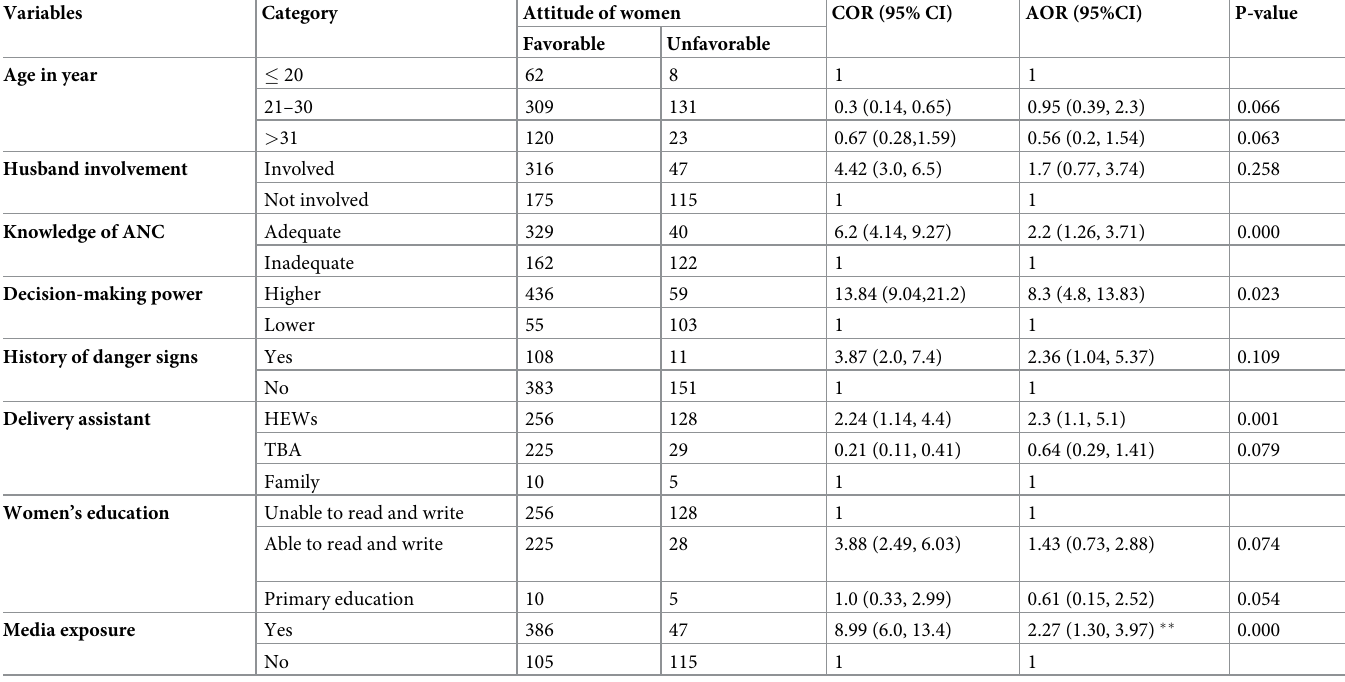
Table 6. Bi-variable and multivariable logistic regression analysis of factors associated with attitude towards antenatal care uptake among women delivered at home in rural Sehala Seyemit district, northern Ethiopia, 2020 (n =